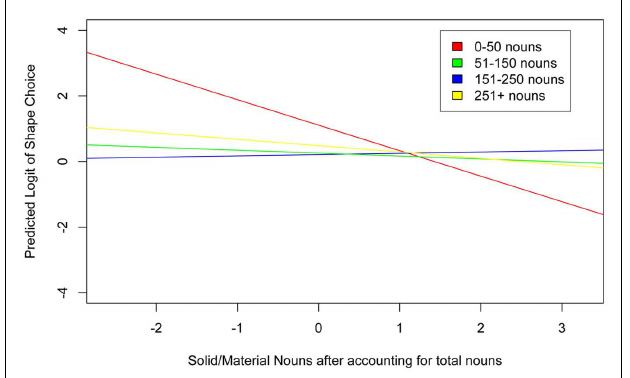
FIGURE 5 | Relationship between number of names of solid objects in material categories a child knows above and beyond what we would expect given their vocabulary group and likelihood of choosing shape